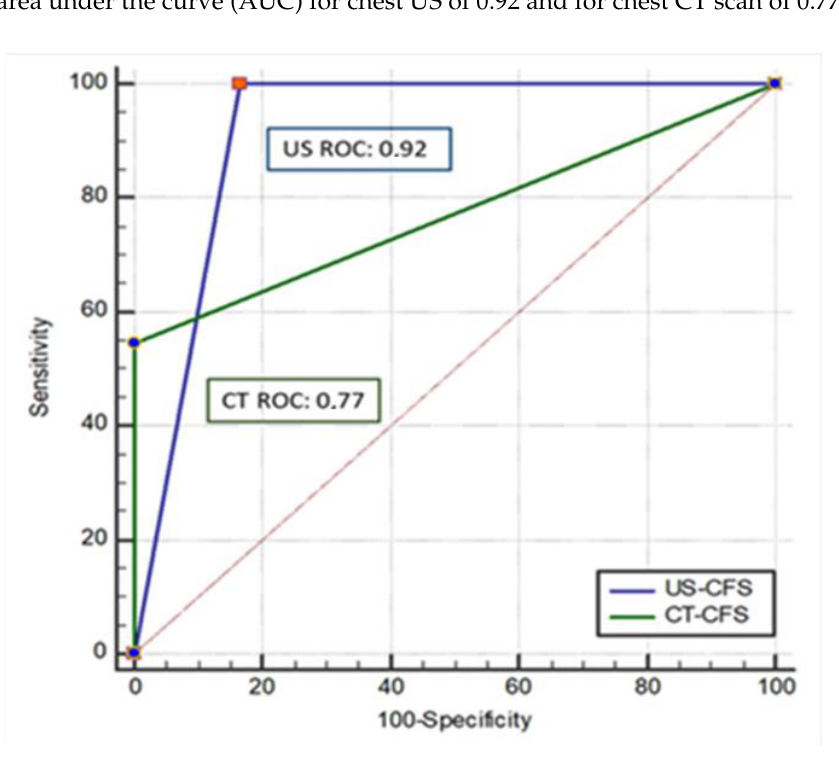
Figure 3. ROC curves for chest US and chest CT scan.